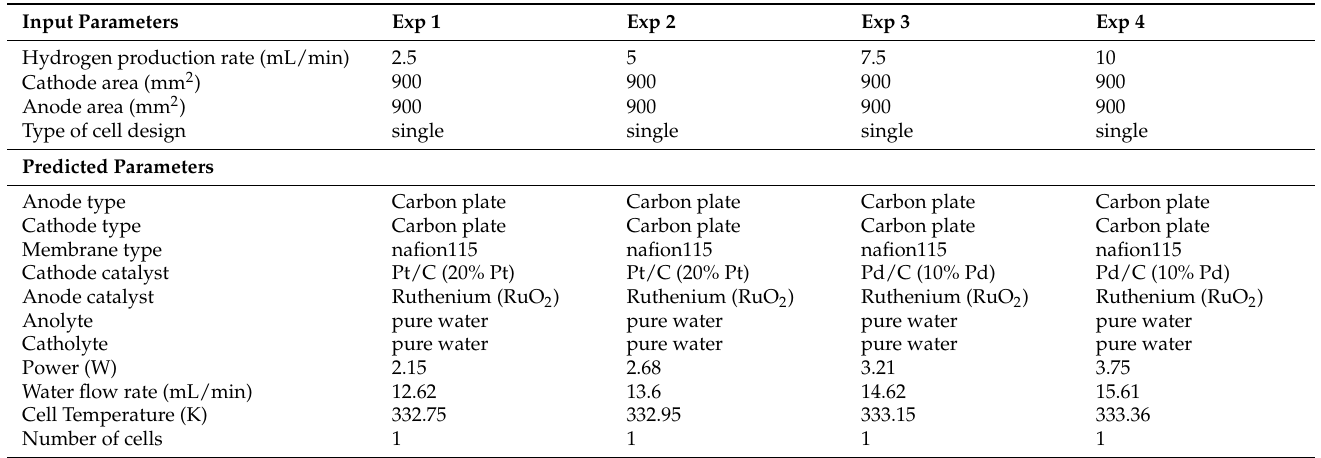
Table 2. Input and predicted PEM cell design by our